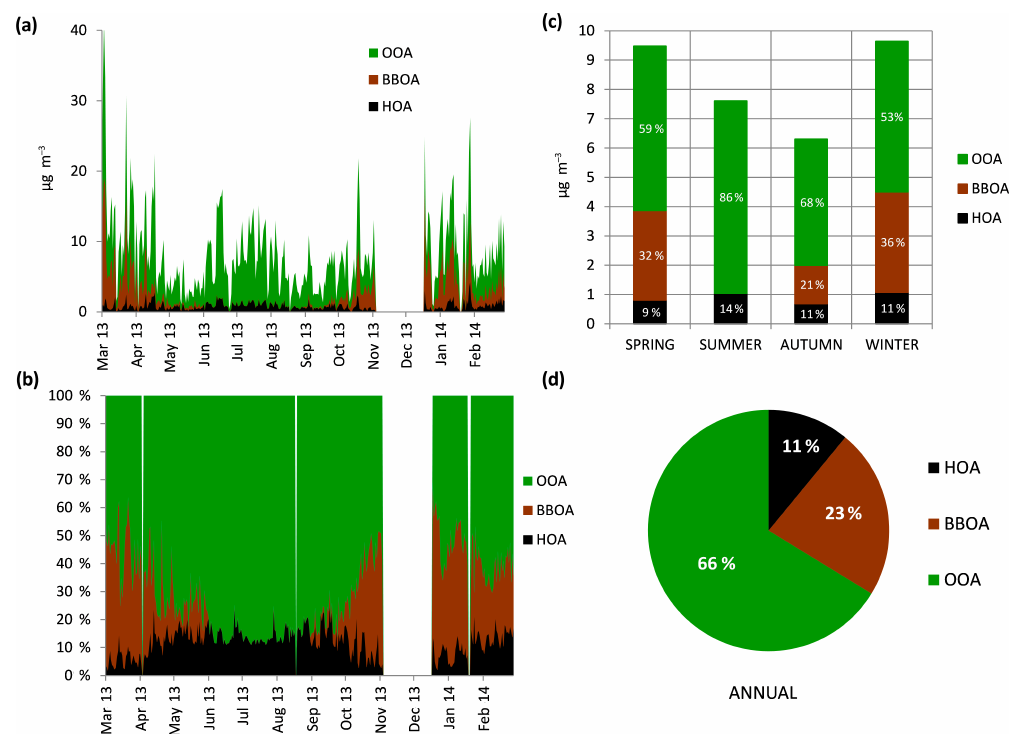
Figure 5. Overview of HOA, BBOA and OOA contributions to organic aerosols; see legend in Fig.